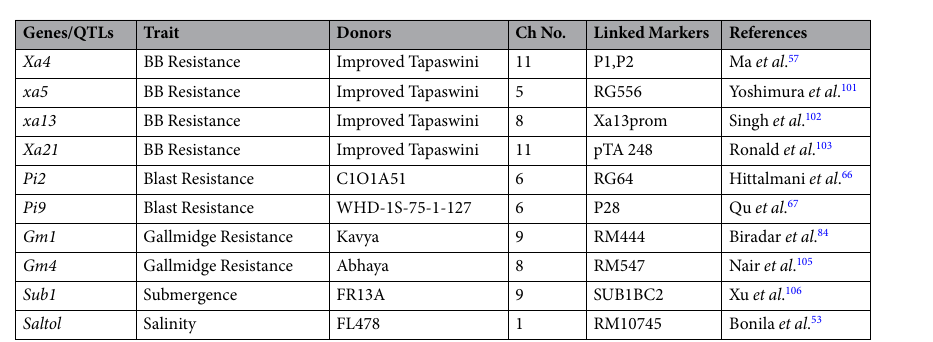
Figure 1. Parental polymorphism survey through PCR assays (cropped gels displayed). ( A ) Amplification with RG64 (digested with HaeIII ) linked to Pi2 . ( B ) Amplification with P28 linked to Pi9 . ( C ) Amplification with RM444 linked to Gm1 . ( D ) Amplification with RM547 linked to Gm4 . ( E ) Amplification with SUB1BC2 linked to Sub1 . ( F ) Amplification with RM10745 linked to Saltol . Arrows indicates amplicons linked to resistance and susceptible alleles.